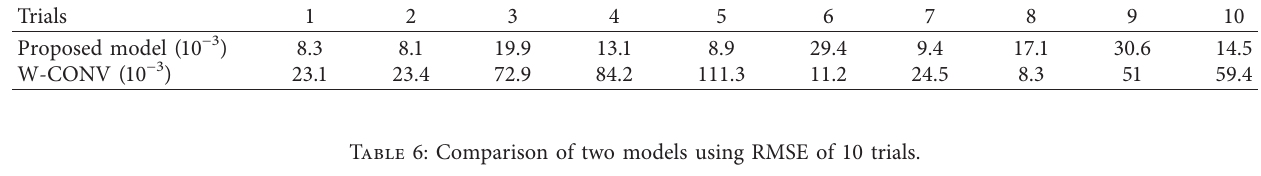
Table 5: Comparison of two models using MSE of 10 trials.